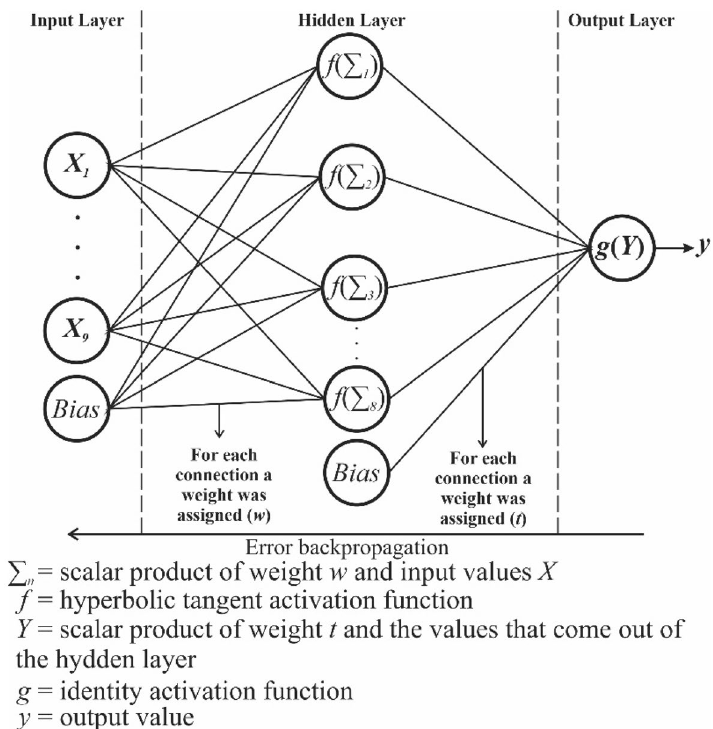
Figure 3. Diagram of the ANN